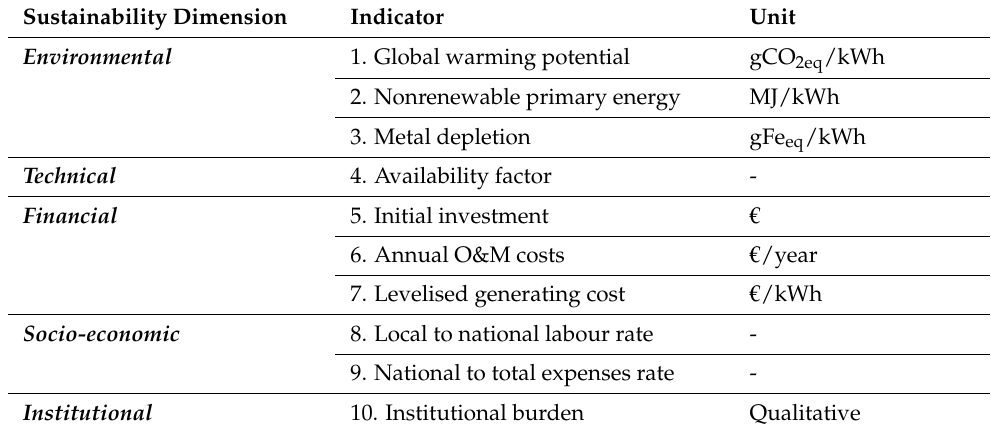
Table 1. The set of sustainability indicators employed for the assessment of the SWT alternatives. Sustainability Dimension